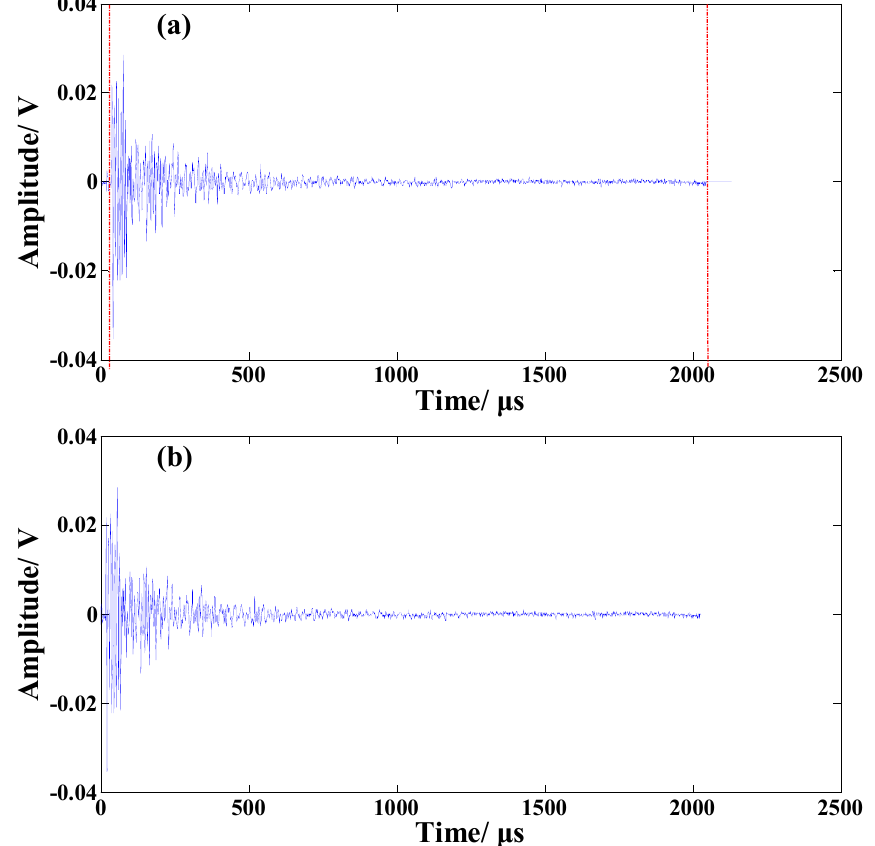
Figure 5. The waveform processing of a typical acoustic signal obtained from Q235 carbon steel in NaHCO 3 + NaCl solution: ( a ) original, ( b ) pre-trigger removal and tail cutting.